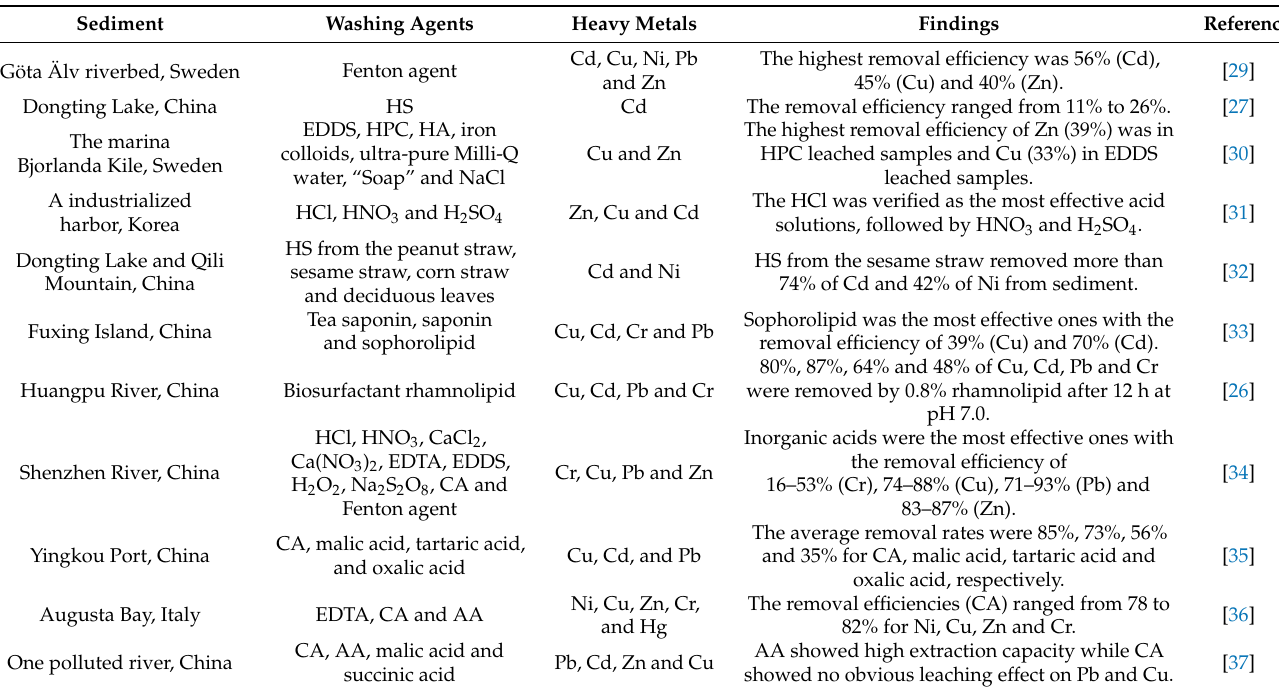
Table 1. Sediment washing for heavy metal contaminated sediment in recent